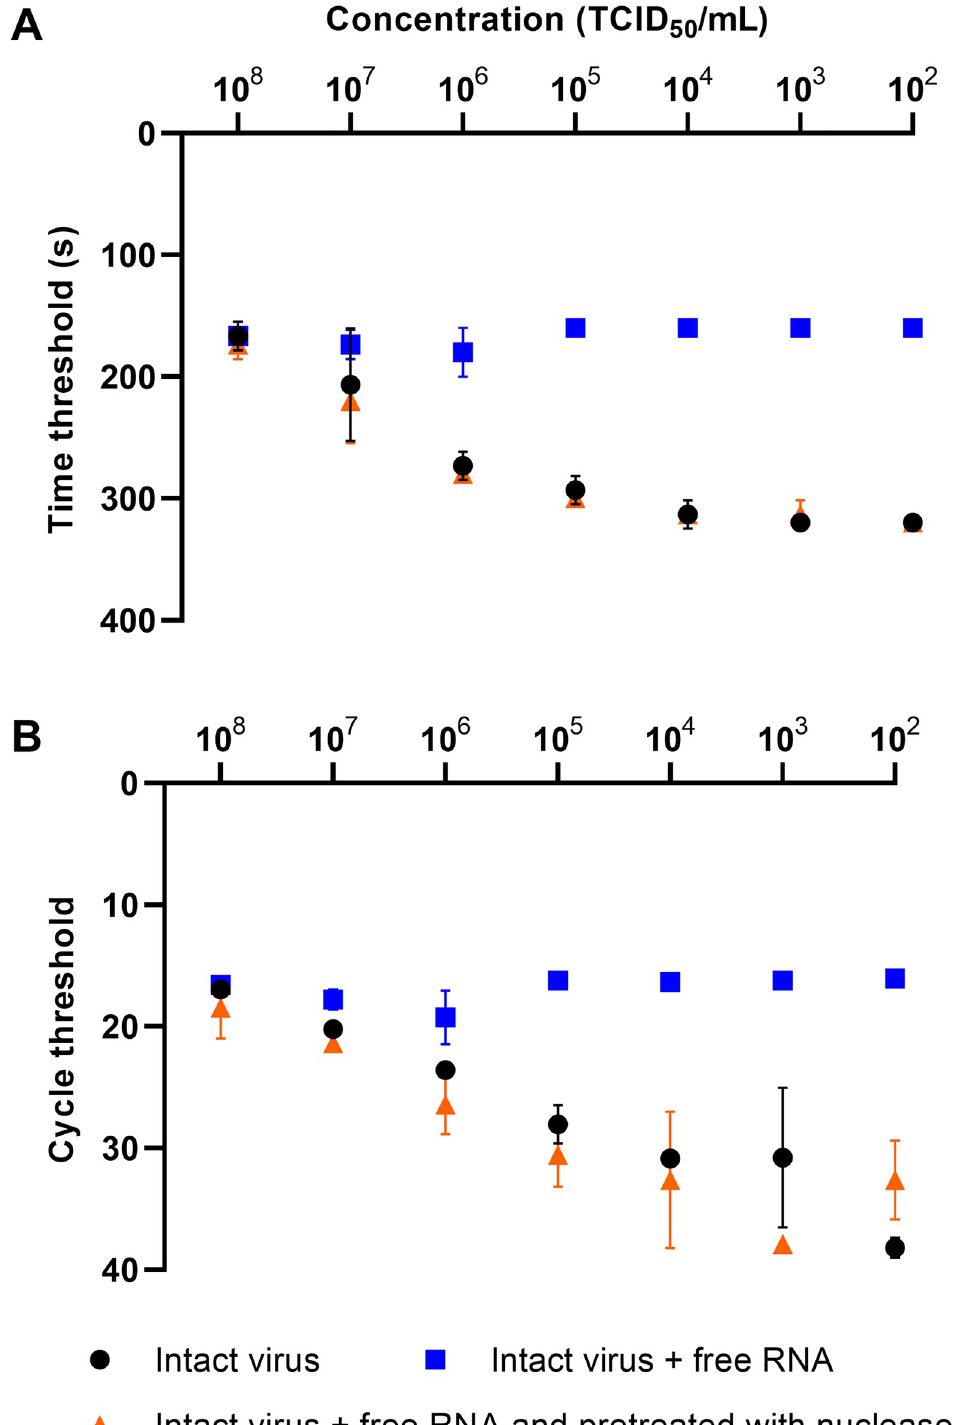
Fig 5. Effectiveness of the universal nuclease on spiked samples with free RNA. In both RT-RAA (A) and real-time RT-PCR (B), the free RNA was degraded when pretreatment with the universal nuclease was performed (orange triangles). The concentrations of those samples correspond to the concentrations of intact virus particles without free RNA and pretreatment; therefore, the orange triangles and black dots overlap. For both RT-RAA and RT-PCR, the differences between intact viruses plus free RNA and intact viruses plus free RNA pretreated with universal nuclease